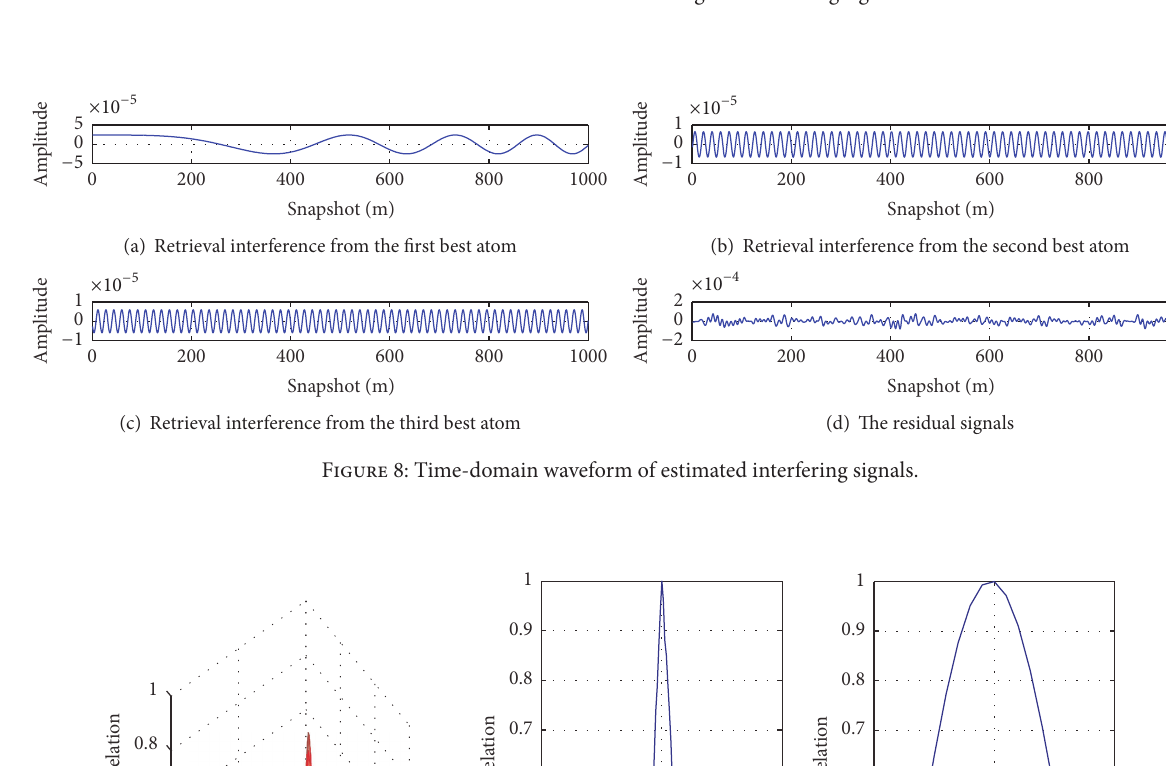
Figure 7: Time-domain waveform of original interfering signals.